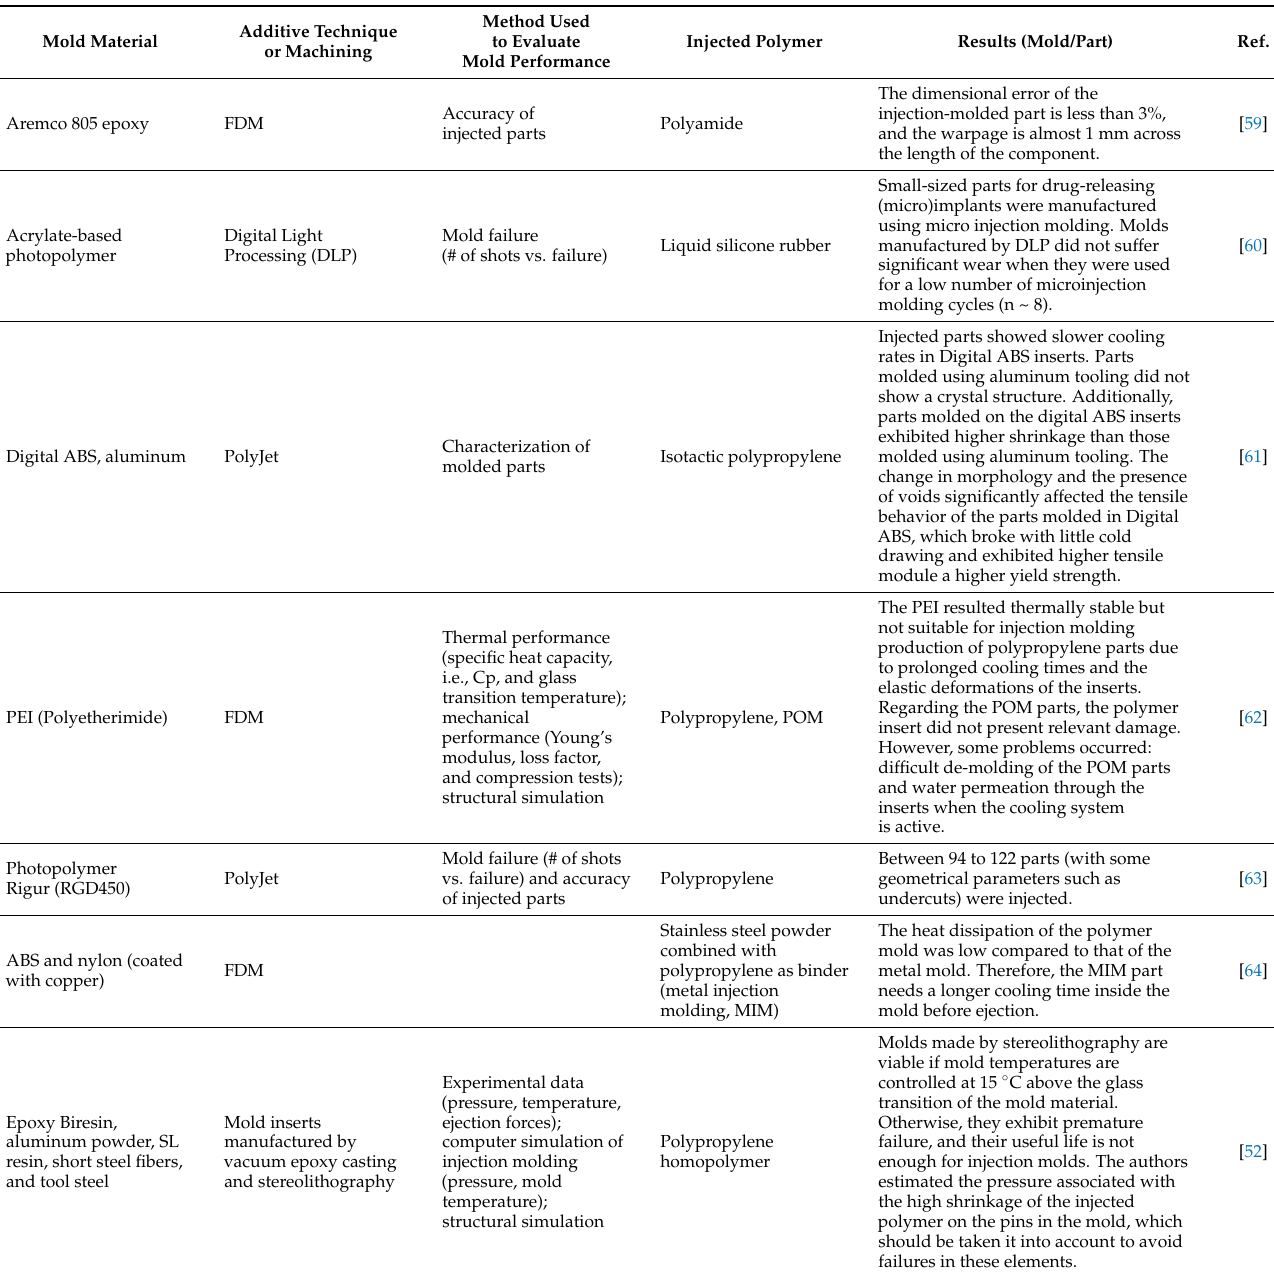
Table 3. Summary of studies that have evaluated different polymer RTIM